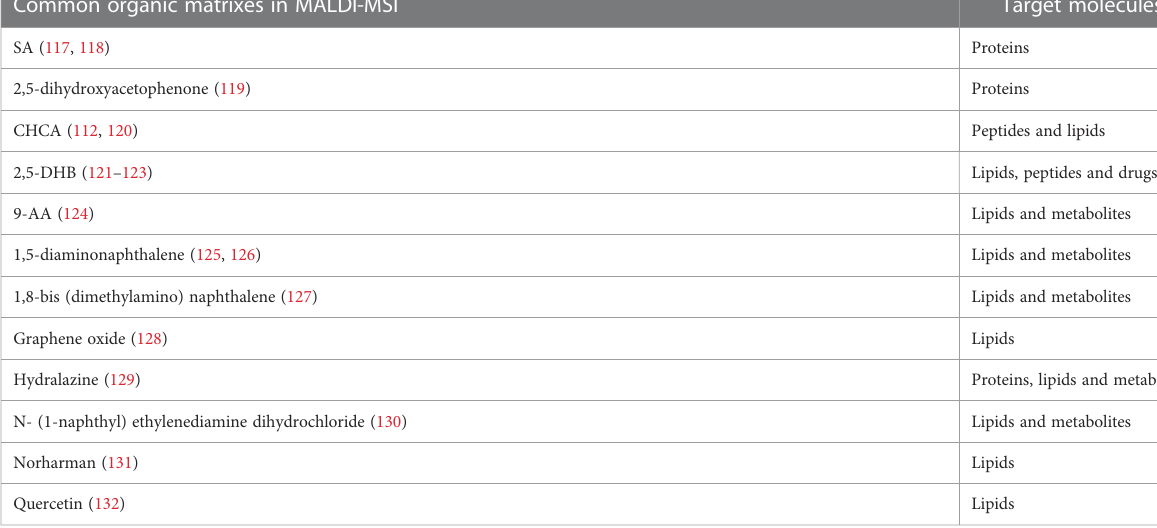
TABLE 2 Common organic matrixes applied in MALDI-MSI. Common organic matrixes in